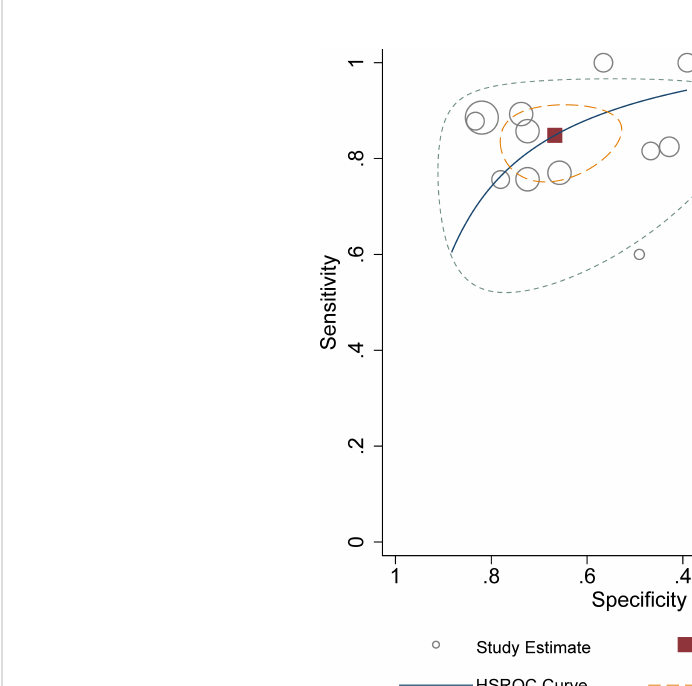
FIGURE 5 HSROC plots with summary point and 95% con fi dence area for the